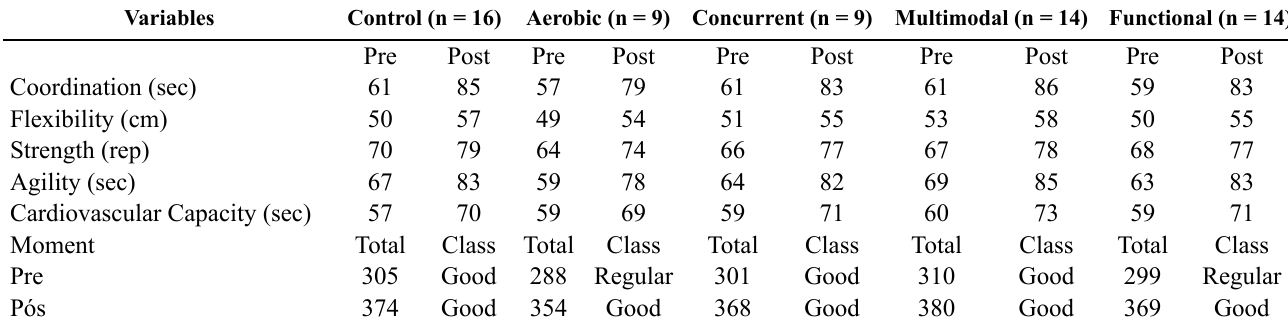
Table 4 General Physical Fitness Index (GFFI) according to the proposal of Zago and Gobbi, 2003 with normative values for postmenopausal